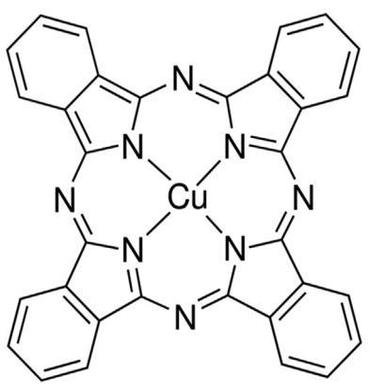
Copper phthalocyanine molecule. A Cu2+ cation occupies the central cavity of the macrocycle forming covalent bonds with N.